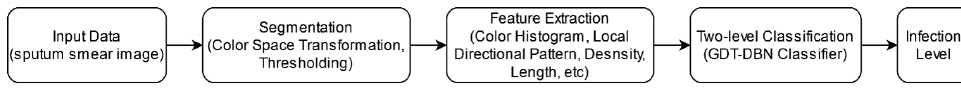
Figure 5. Block diagram of GDT-DBN classification for TB infection level identification